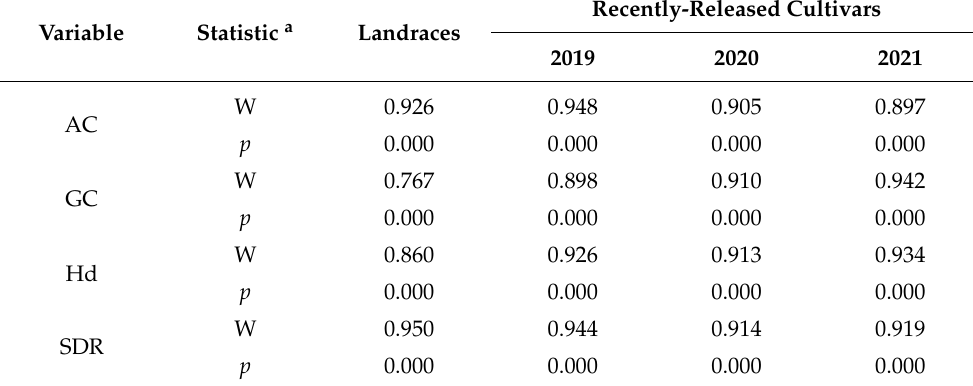
Table 2. Shapiro–Wilk test of normality of data of amylose content (AC), gel consistency (GC), hardness (Hd), and starch digestion rate (SDR) in landraces and recently-released cultivars of indica rice in